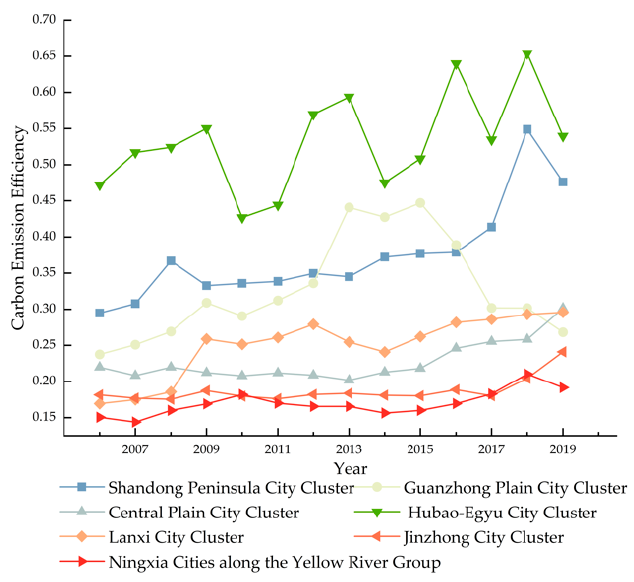
Figure 2. Changes in carbon emission efficiency by city cluster. The seven city clusters are separated into up, middle, and downstream city clusters due to the contrasting geographic circumstances of the Yellow River’s upstream and down- stream. The upstream city cluster includes Lanxi city cluster, Ningxia along the Yellow River group, and the Hubao-egyu city cluster; the midstream city cluster includes the Guanzhong plain city cluster, the Jinzhon city cluster, and the Central plains city cluster; and the downstream city cluster includes the Shandong peninsula city cluster. Figure 3 demonstrates that, from 2006 to 2019, the midstream city cluster in the Yellow River Basin has a poorer carbon emission efficiency than their upstream and downstream counterparts. Among these, the downstream city cluster, specifically the Shandong Peninsula city cluster, is the leader in terms of its high carbon emission efficiency. High carbon emission efficiency is directly associated with optimizing the industrial structure and enhancing economic growth in the downstream area. In the Yellow River Basin, the midstream city cluster is a region where heavy industrial bases are concentrated. Therefore, the city cluster in the midstream has features of high energy consumption and energy reliance. Simultaneously, industrial upgrading is complicated and urban transformation is challenging, reducing the efficiency of midstream carbon emission. In addition, the Chinese government launched the concept of high-quality development in 2017, which demands optimizing the energy structure, focusing on innovative development, and reforming the old approach to devel- opment. In 2018, however, all city groups improved their carbon emission efficiency due to a policy